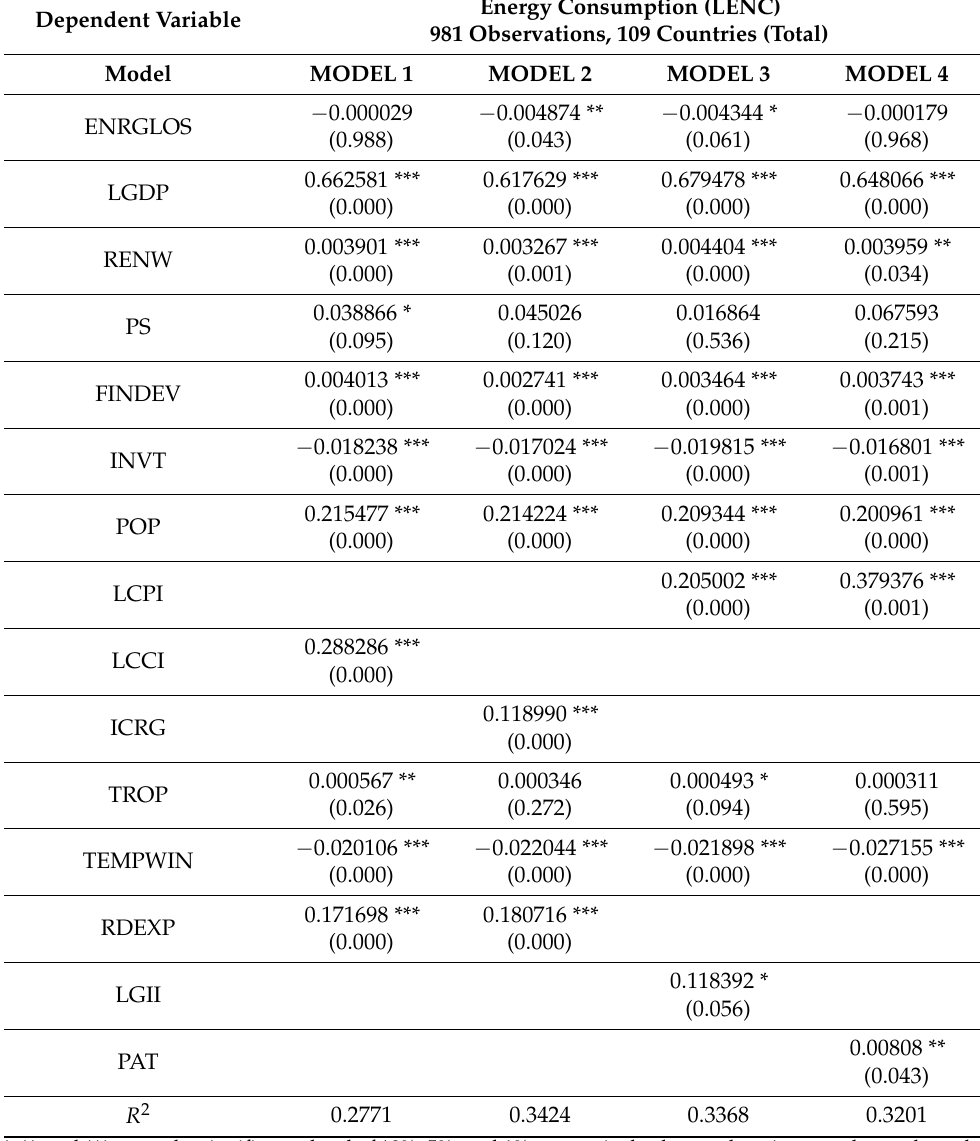
Table 6. Energy consumption and its determinants: alternative variables for corruption and innova- tion with the FMOLS estimation